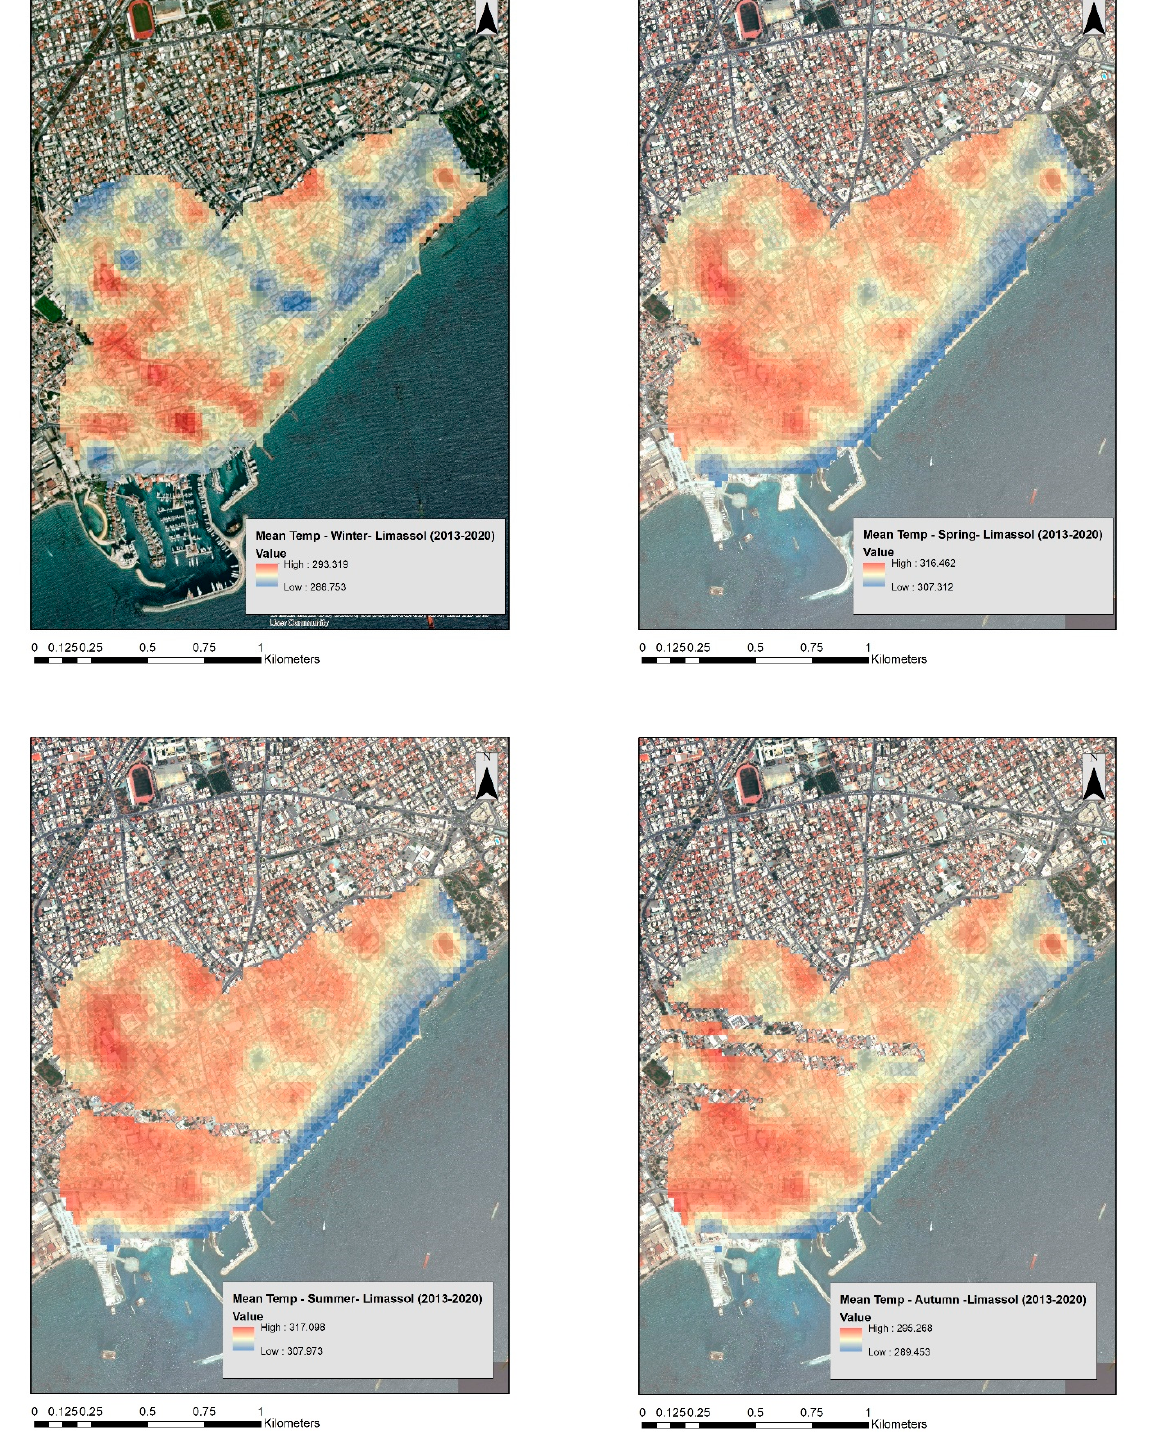
Figure A2. Seasonal mean temperature over the Limassol area, between the years 2013 and 2020. The red colour indicates higher mean temperatures, while the blue colour indicates lower mean temperatures.